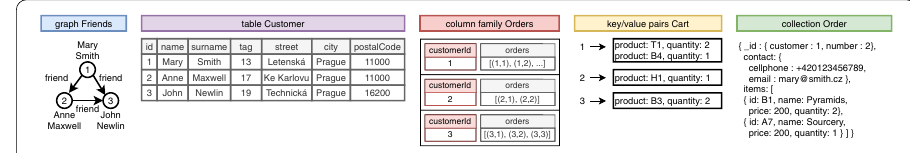
Fig. 1 A sample multi-model scenario